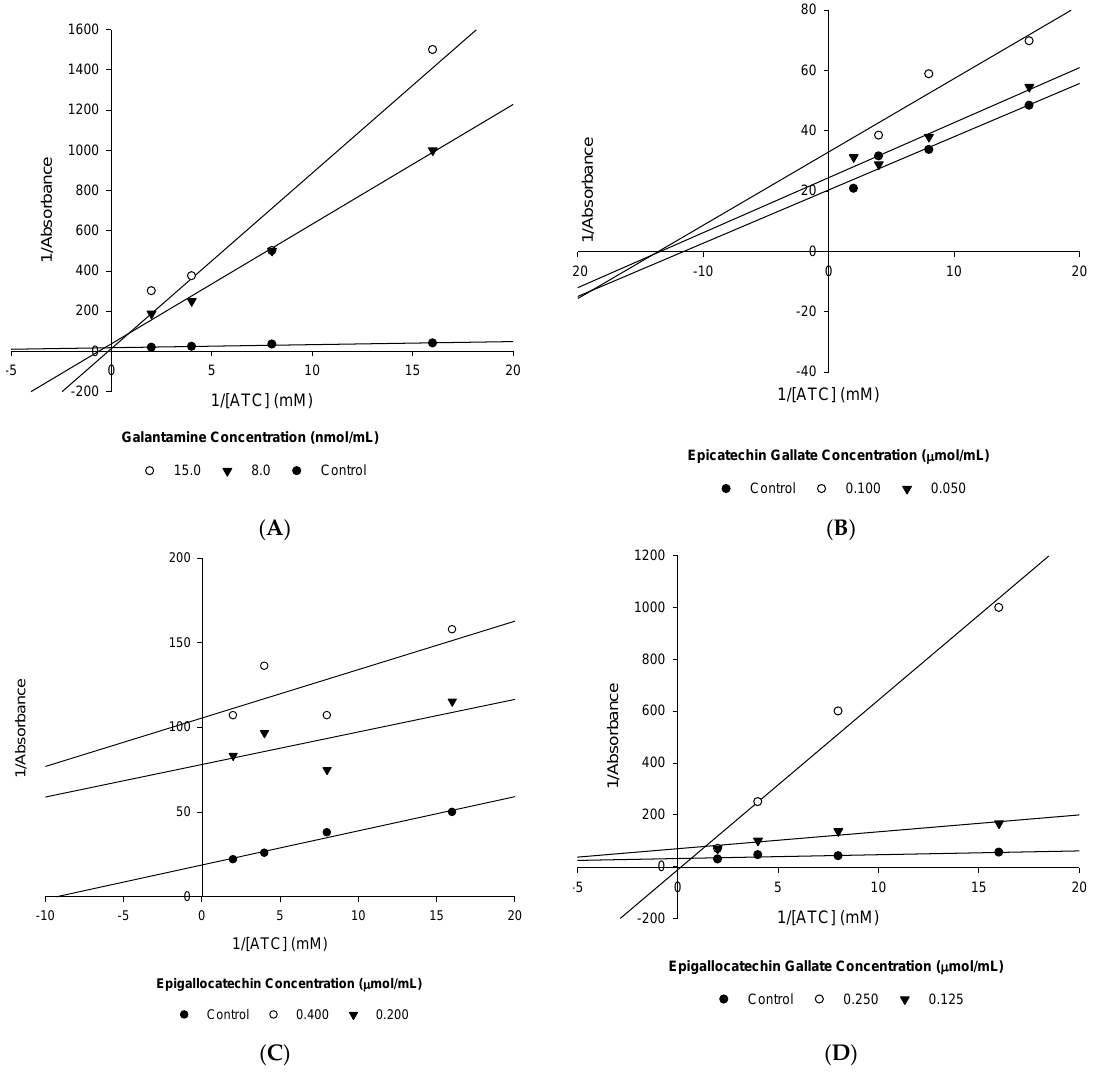
Figure 2. Lineweaver–Burk plots: ( A ) Gal, ( B ) ECG, ( C ) EGC and ( D ) EGCG. From these plots, the V MAX and K M were calculated (Table 7), allowing the type of enzyme inhibition present to be confirmed.